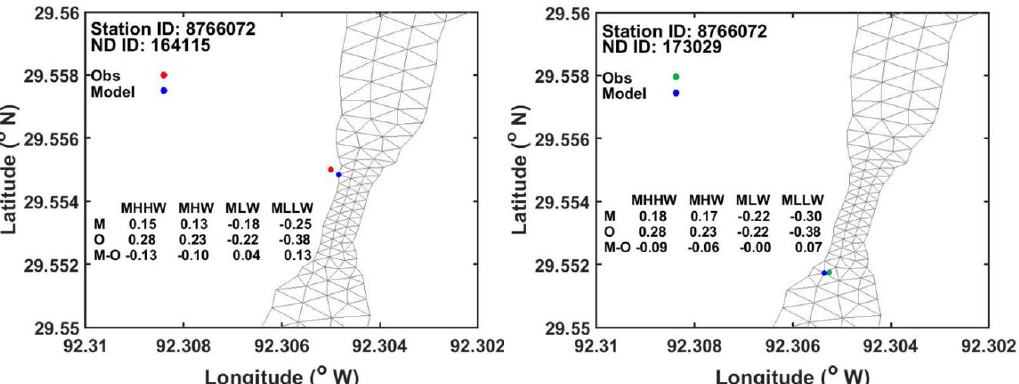
Figure 8. Modeled and observed tidal datums (in units of meters) at Station #8766072 before ( left ) and after ( right ) correcting the station’s coordinates. “Obs” and “O” refer to “Observation”. “M” refers to “Model”. “ND ID” refers to “model node (grid point) identification”.